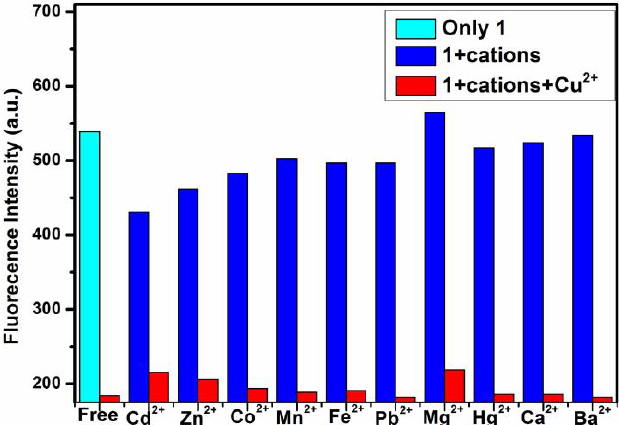
Figure 3. Fluorescence intensity measured at 387 nm for Probe 1 in ethanol (10 μM) in the absence of metal ions ( Green ), and in the presence of 10 μM various metal ions ( Blue ); 10 μM Cu 2+ was added to each of the 11 solutions and the fluorescence intensity was measured again for comparison ( Red ).